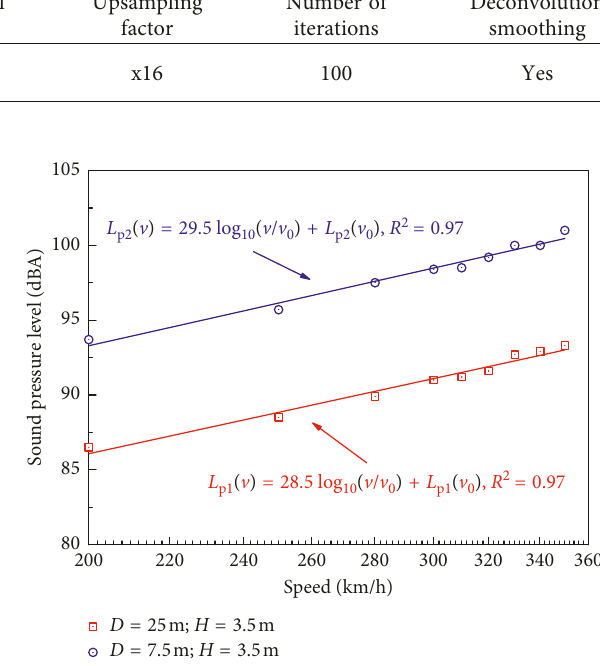
Figure 3: Time histories of the pass-by noise at different mea- surement points (350 km/h).